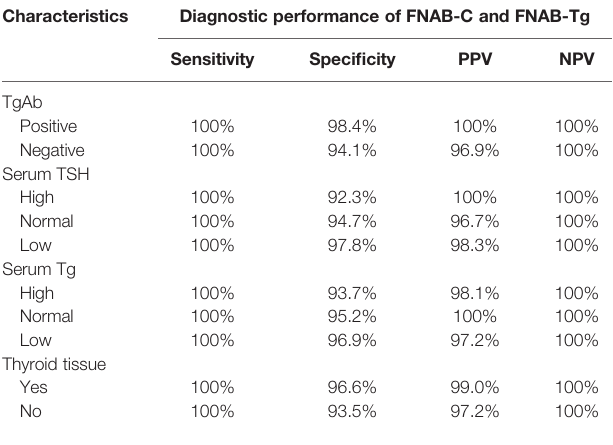
TABLE 6 | Association between TgAb, serum TSH, serum Tg, thyroid tissue and the diagnostic performance of FNAB-C and FNAB-Tg in positive lymph nodes.